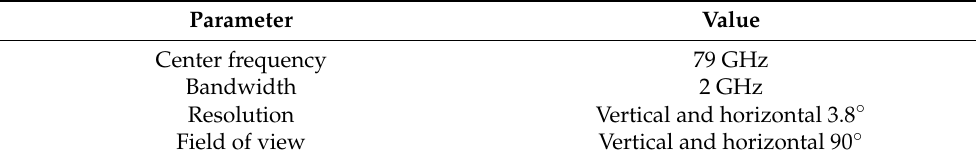
Table 1. Radar specification.